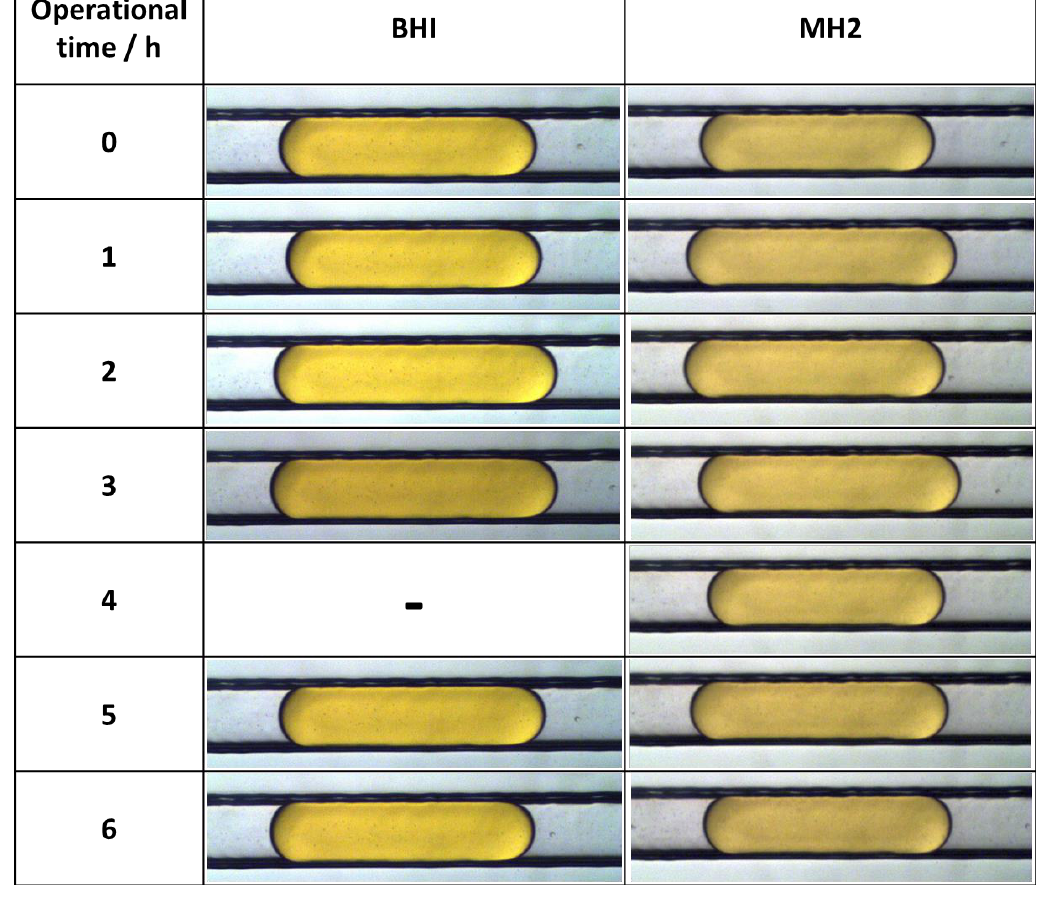
Figure 8. The stability of NH 3(aq) modified surface of PC microdevice was tested for 6 h of continuous work. During the test we used Novec 7500 with 1% PFPE-PEG-PFPE as a continuous phase and BHI and MH2 as an aqueous phase in flow-focusing microsystem.